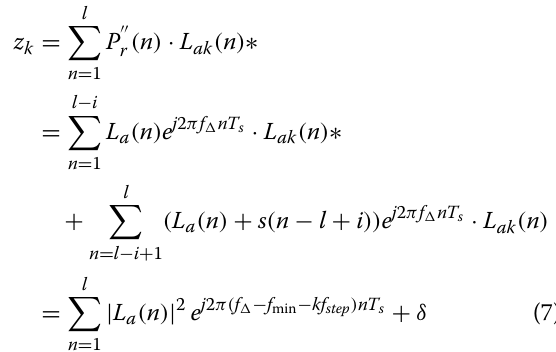
Table 2 in Section 4. When ( f min + k · f step ) = f (cid:3) , z k obtains l (cid:2) its maximum value n = 1